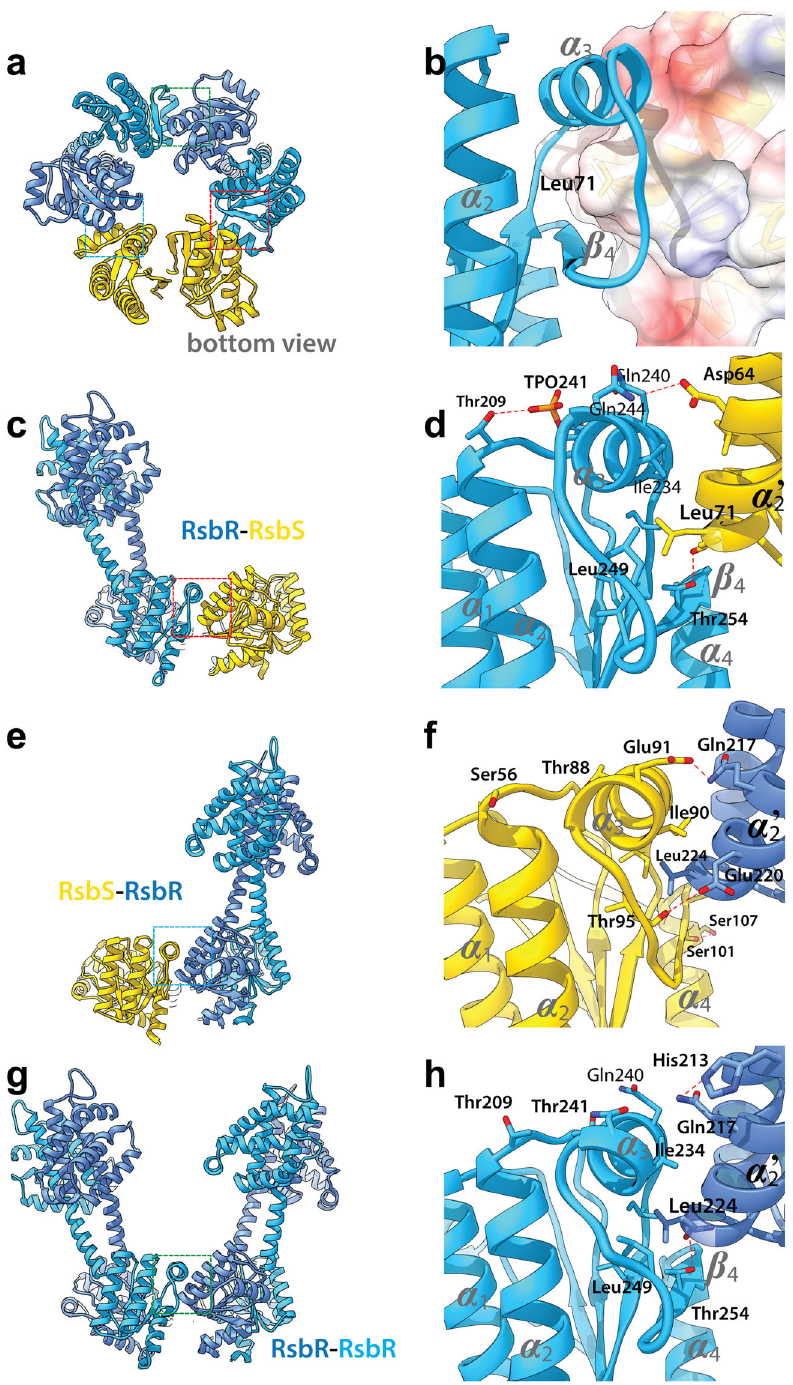
Fig. 4 Interdimer interaction surfaces in the RsbR:RsbS heterotriangle. The three unique interaction surfaces can be seen from the bottom in ( a ) and from the side in ( c ), ( e ) and ( g ). A surface rendering of RsbS and the sidechain in the hydrophobic pocket can be seen in ( b ). Leu71 from the ɑ 2 helix of RsbS can insert into the hydrophobic pocket formed by ɑ 3 and β 4 of RsbR ( d ), the interaction further strengthened by hydrogen bonds formed between Glu91 of RsbS and Gln217 on RsbR. A very similar interaction occurs between ɑ 2 of RsbR and the adjacent RsbS ( f ) or RsbR ( h ) protomer, where Leu224 inserts into the hydrophobic pocket former by ɑ 3 and β 4 of the adjacent STAS domain